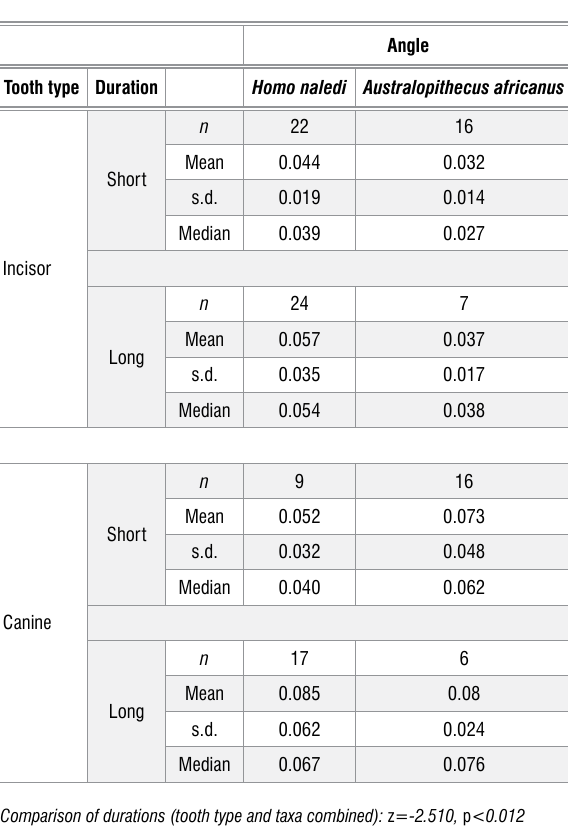
Onset angle (tan theta) of linear enamel hypoplasia LEH furrow defects compared between durations, tooth types and taxa